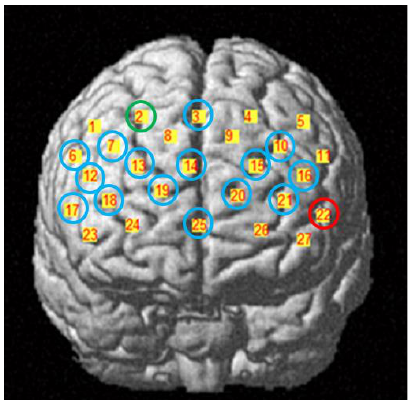
Figure 6. The results of nodal efficiency and complexity. The number on the yellow square back- ground represents the position of the 27 channels. The blue circle denotes channels with increased nodal efficiency; the green circle denotes channels with decreased nodal efficiency; the red circle denotes channels with decreased complexity.